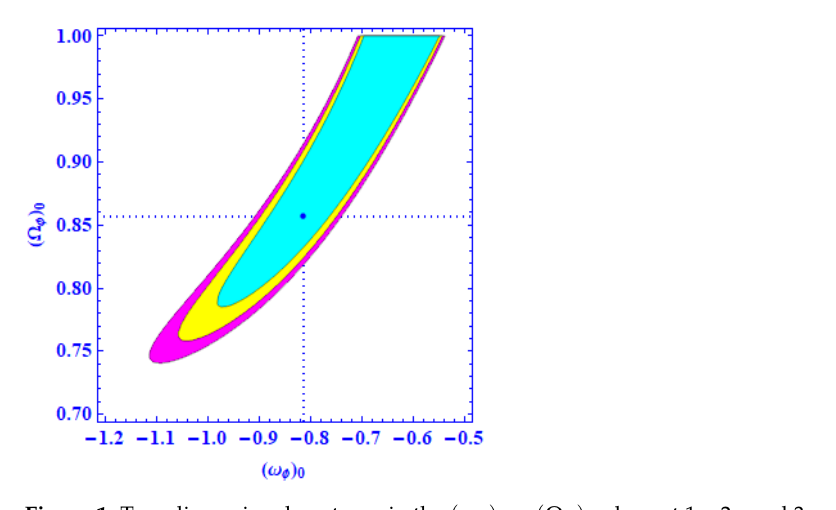
Figure 1. Two-dimensional contours in the ( ω φ ) 0 − ( Ω φ ) 0 plane at 1 σ , 2 σ and 3 σ confidence regions by bounding our model with H ( z ) data. Table 2. Constrained values of model